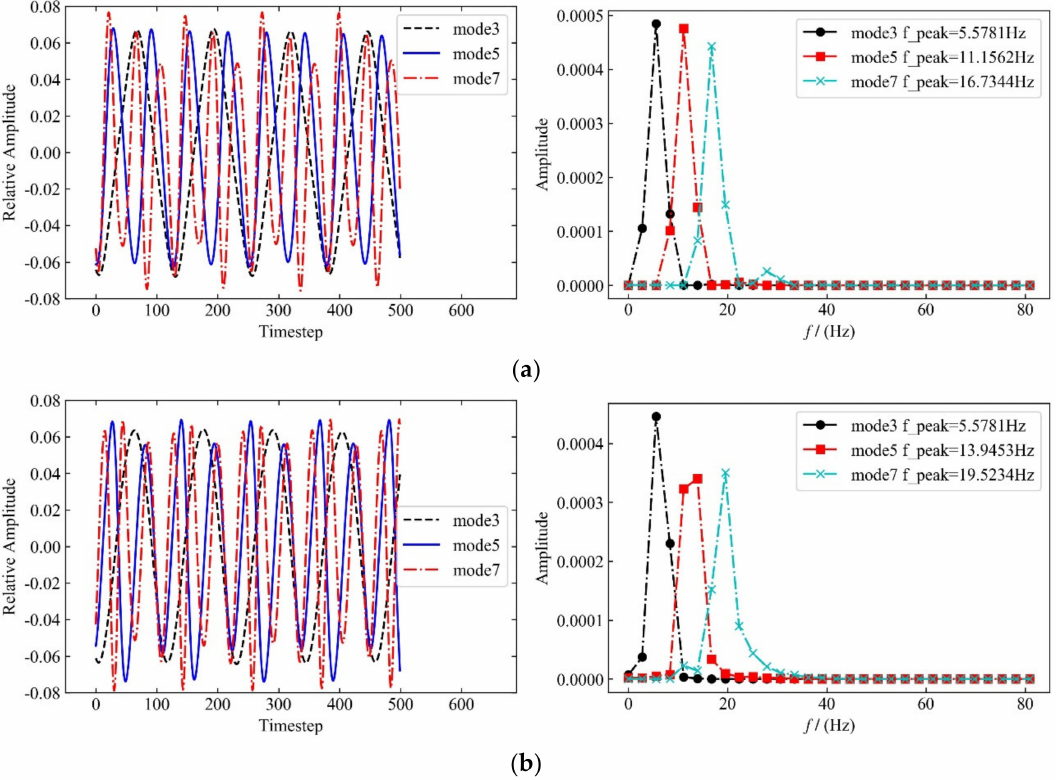
Figure 9. Time travel curve and Fourier power spectra of the dominant pod modes: ( a ) L / D = 2.5; ( b ) L / D =